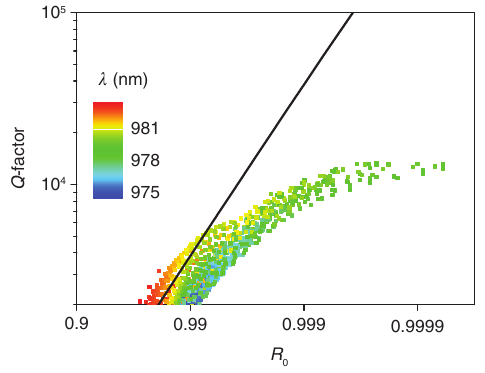
Figure 5: Q -factor of a D-D microcavity as function of the 0-DO power reflectance ( R ) of the DBR (black line) and the M-D 0 microcavity as function of the 0-DO power reflectance ( R standing infinite MHCG (points).